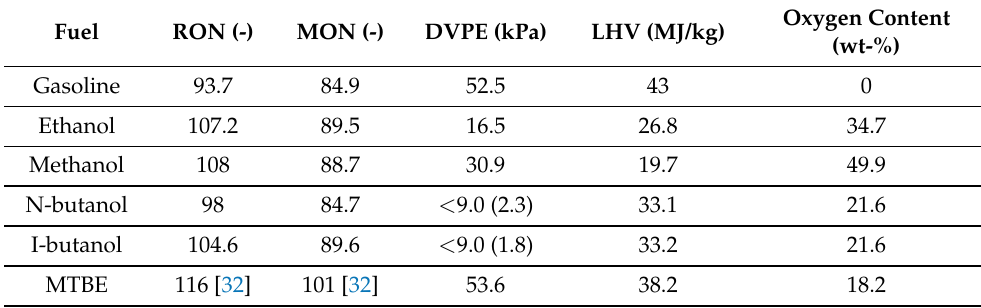
Table 2. Properties of the tested oxygenated